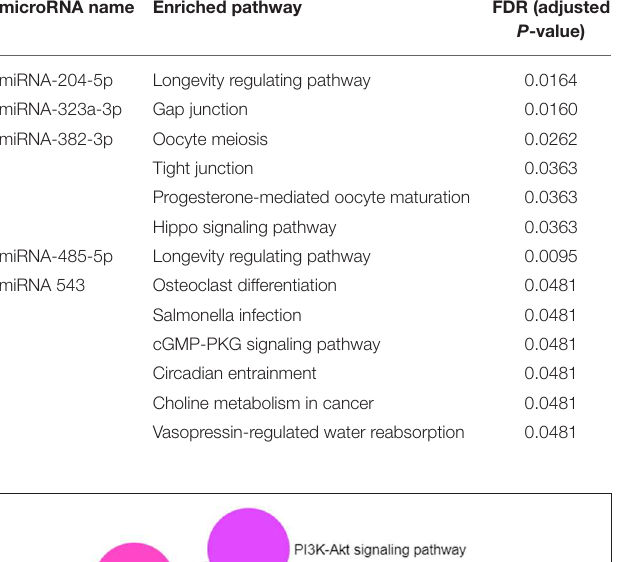
TABLE 2 | Significantly enriched pathways of target genes from the identified miRNAs using NetworkAnalyst with p < 0.05.